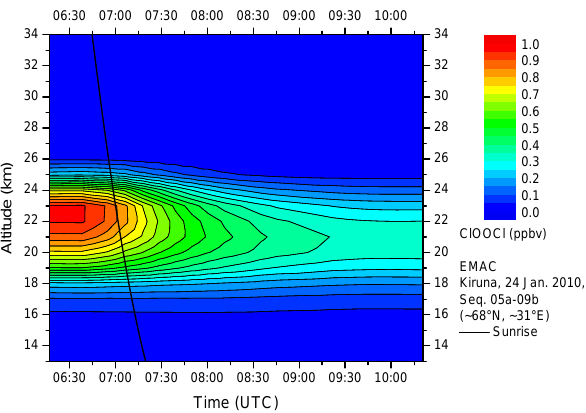
Fig. 8. ClONO 2 mixing ratios as seen by MIPAS-B above northern Scandinavia on 24 January 2010 inside the polar vortex. Very low ClONO 2 values below 24 km coincide with high amounts of activated chlorine.